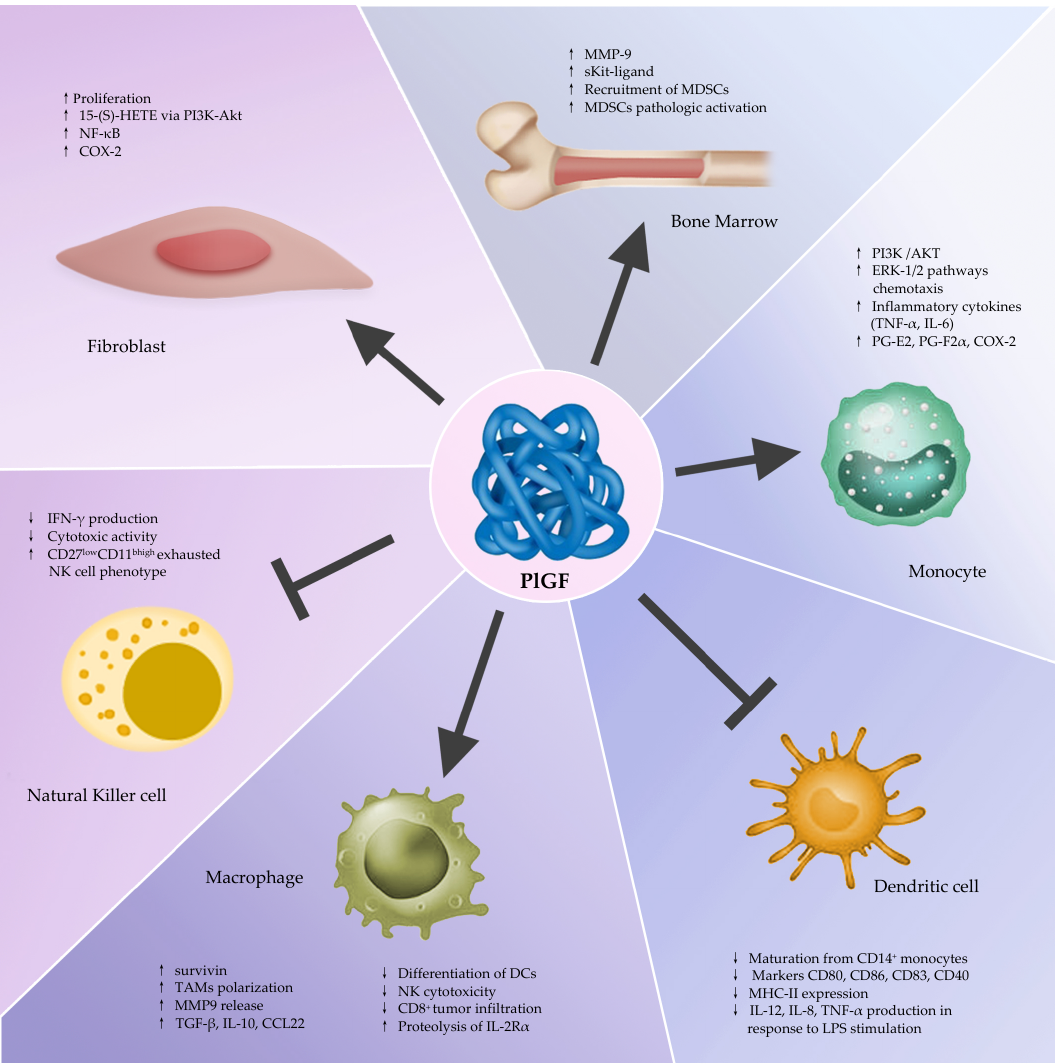
Figure 1. Pleotropic e ff ects of placental growth factor. PlGF promotes the recruitment of VEGFR1 +